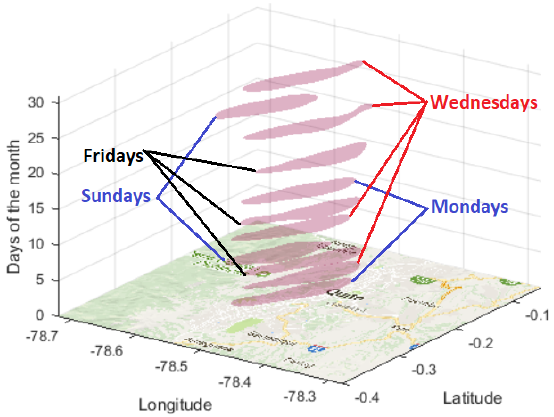
Figure 9. Spatiotemporal emergency slices for police during December (only 11 nonconsecutive days are illustrated for better visualization on page). It is easy to notice with this representation the variations in the geographical concentration of events during the month and its concentration over different regions of the